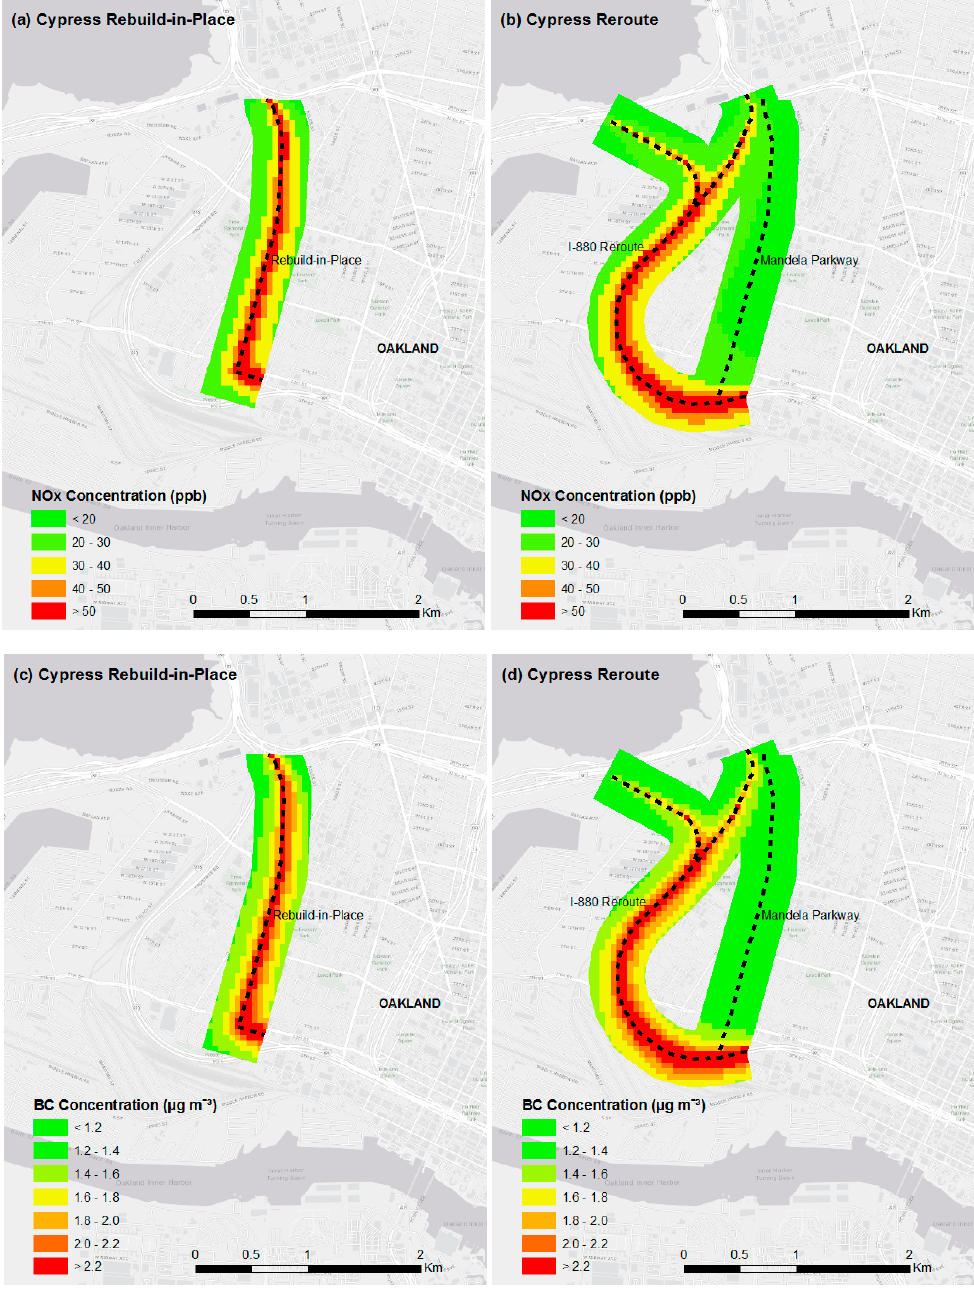
Figure 2. Annual average concentrations in West Oakland for ( a , c ) the Cypress rebuild-in-place scenario, and ( b , d ) the Cypress reroute scenario. Dashed black lines represent the centerline of each route.